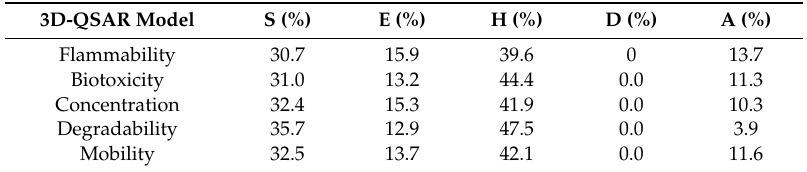
Table 5. Molecular force field contribution rates of PAEs’ flammability, biotoxicity, enrichment, degradability, and mobility